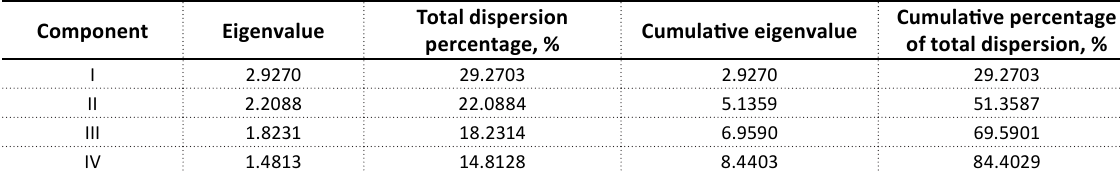
Table 1. Dispersion and eigenvalues of main components of the investigated enterprises’ investment activity